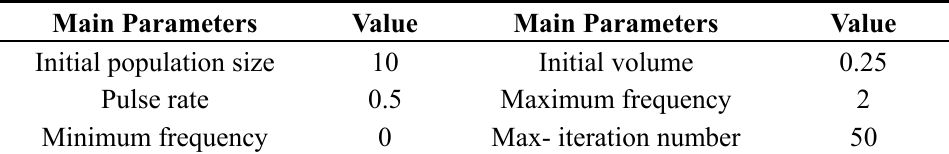
Table 6. Parameters of